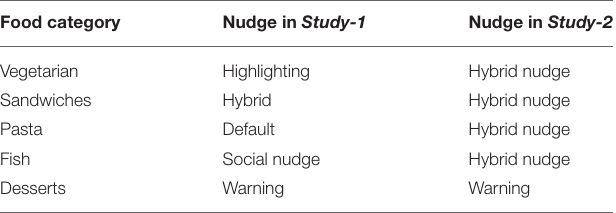
Fish Hybrid nudge Desserts Warning